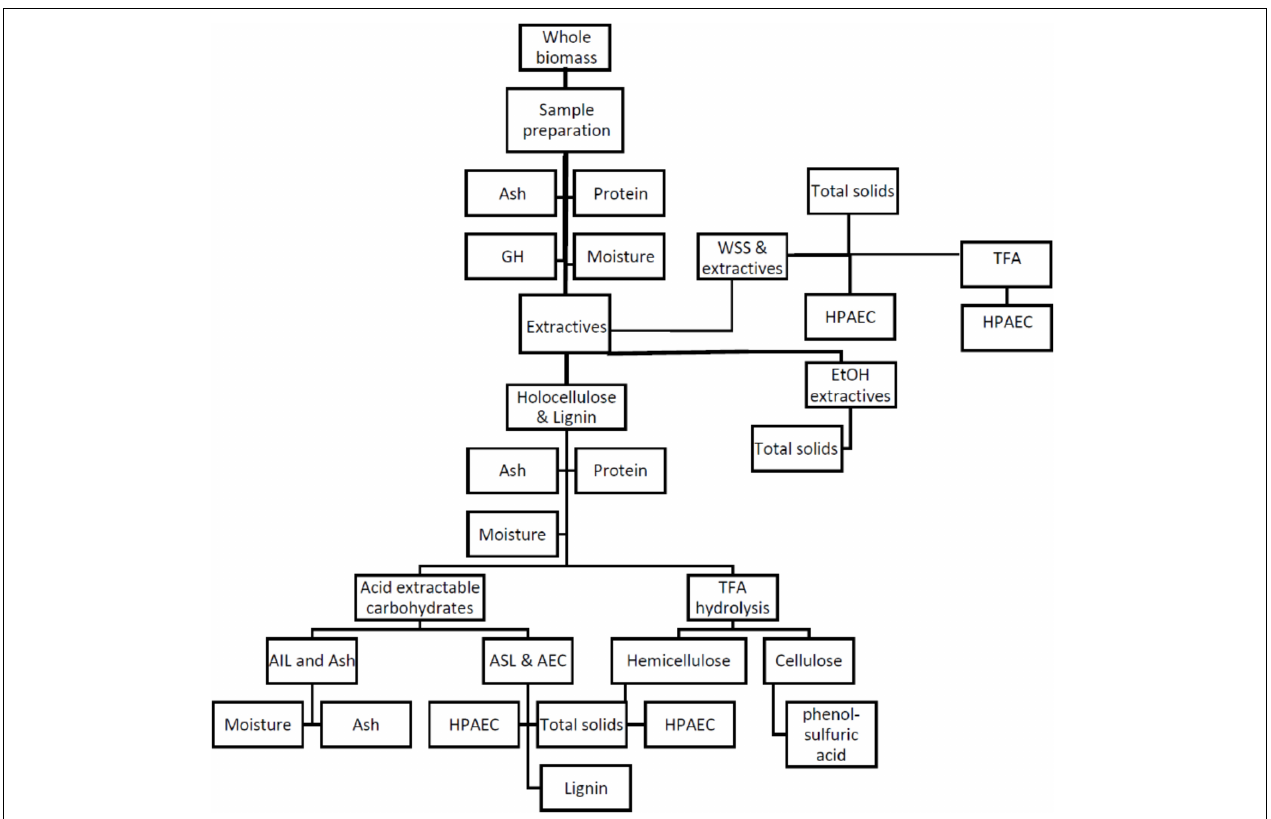
FIGURE 1 | Flowchart outlining the composition analysis procedures for A. americana adapted from Sluiter and Sluiter (2011). Whole biomass sample is prepared, extracted with water to remove water-soluble carbohydrates (WSS), extracted with ethanol to remove inhibitors from residue containing holocellulose and lignin, which is then hydrolyzed to solubilize some lignin (ASL) and acid extractable carbohydrates (AEC) ( i.e ., structural carbohydrates) and leave a residue containing insoluble lignin (AIL) and minerals. Water soluble extract and holocellulose fraction undergo TFA hydrolysis and analyzed by HPAEC, and TFA insoluble is analyzed for cellulose content by phenol-sulfuric acid assay. Lignocellulosic grasses were only be analyzed for GH, WSS, and AEC. Procedure short titles are provided in non-shaded boxes, and biomass fraction name is provided in shaded